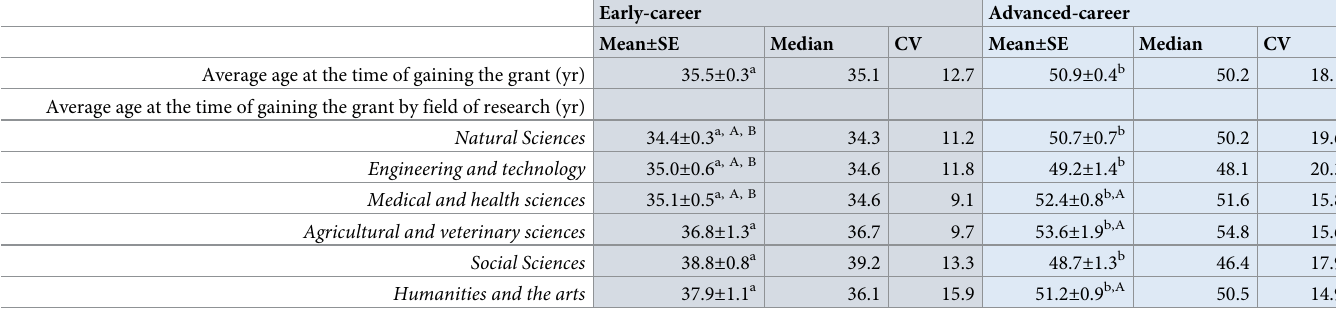
Table 3. Average age of PI at the time of the grant across different fields of science for grants awarded by the Estonian Research Council between 2013–2022 (Research question 1).